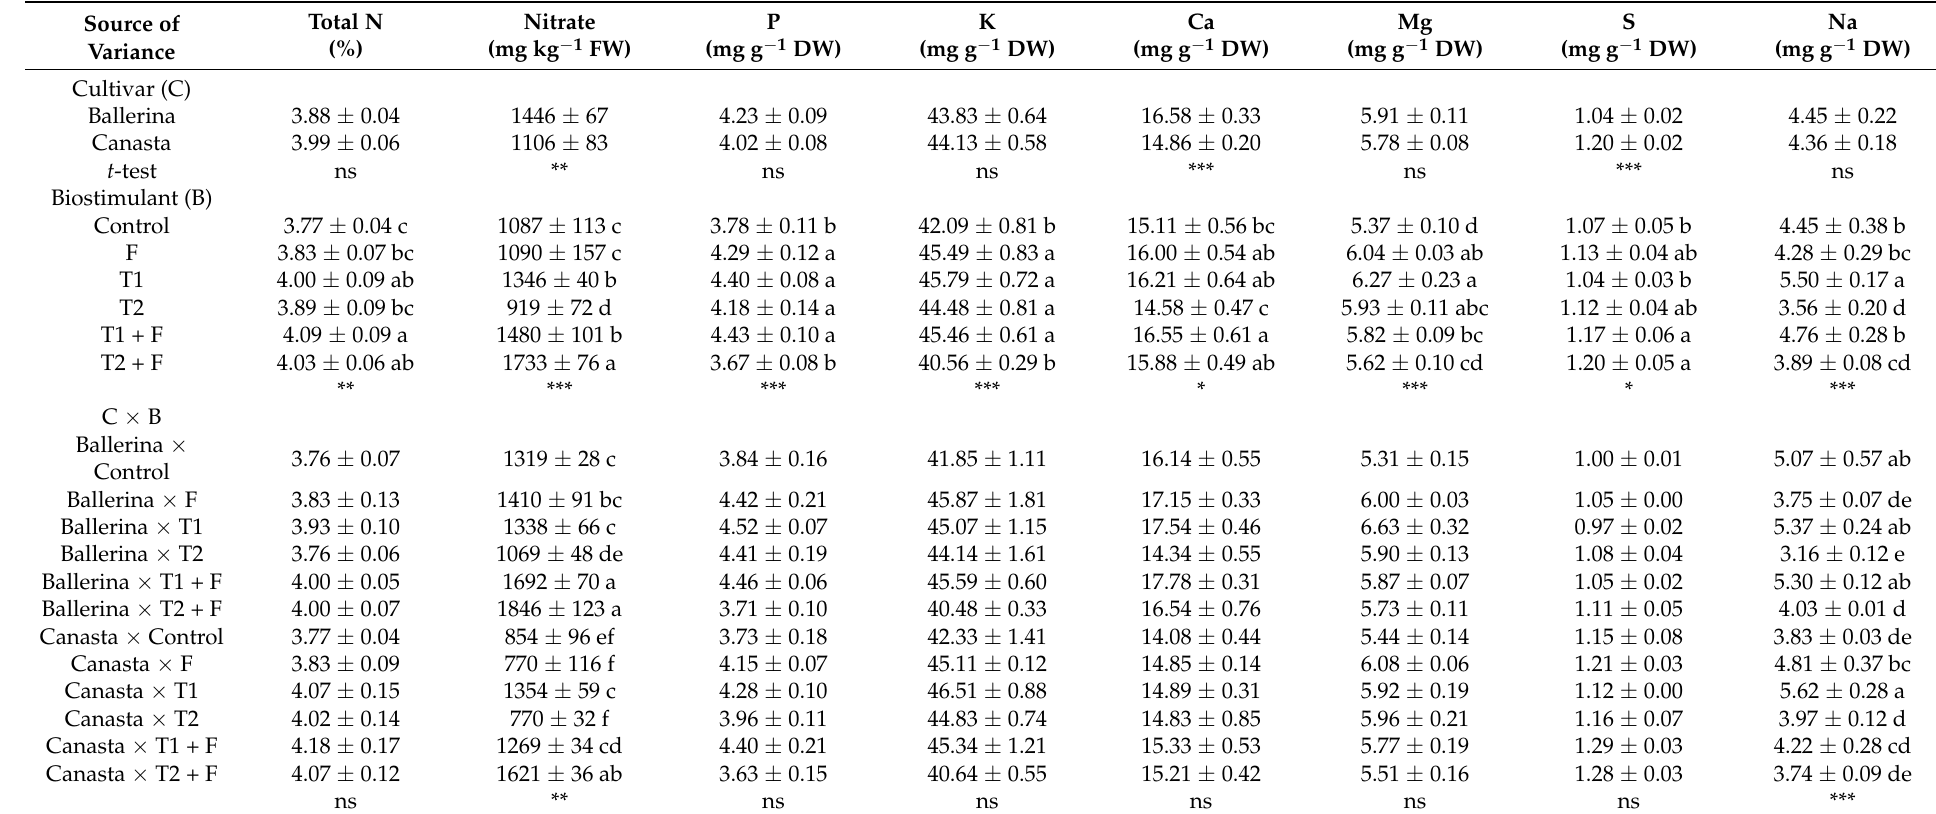
Table 3. Total nitrogen and mineral leaf content (nitrate, P, K, Ca, Mg, S and Na) of ‘Canasta’ and ‘Ballerina’ lettuce as influenced by the biostimulant